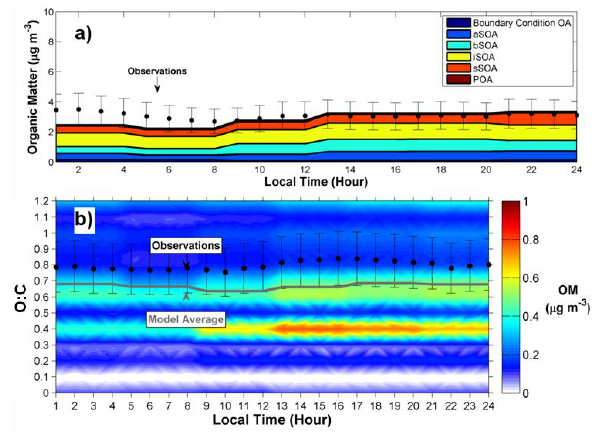
Figure 8. Diurnally averaged a) source resolved mass concentration and b) O:C profiles for the 986 Fig. 8. Diurnally averaged (a) source resolved mass concentration and (b) O:C profiles for the two-bin volatility shift scenario. Ob- two-bin volatility shift scenario. Observations (bullets) appear with error bars indicating 987 servations (bullets) appear with error bars indicating measurement measurement uncertainty. 988 uncertainty.